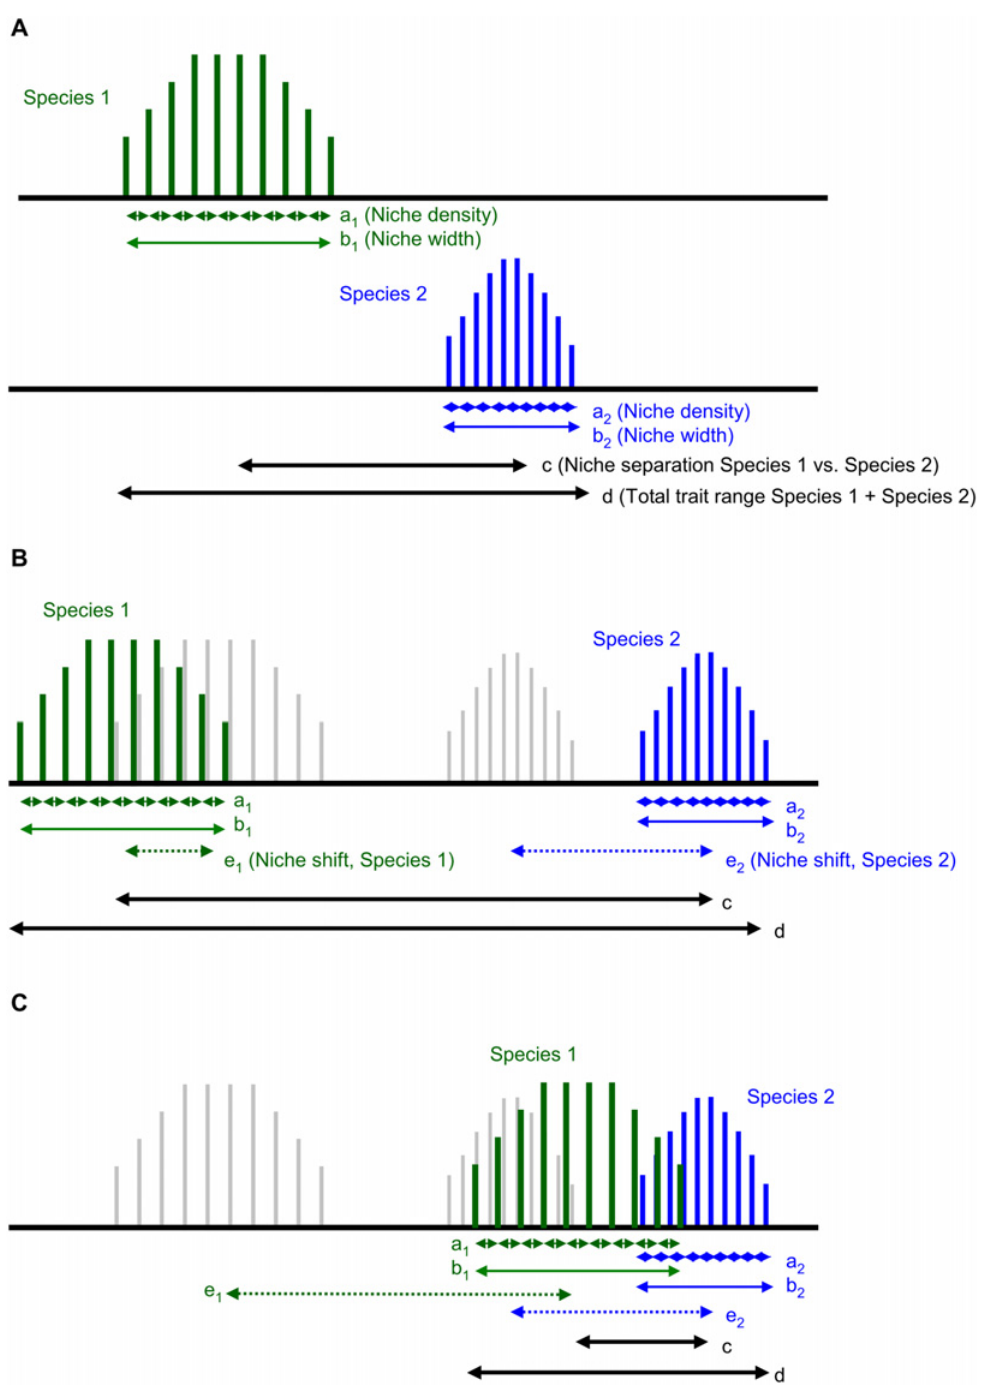
Fig 1. Quantification of species niches along a trait axis. For simplicity only two species (Species 1, Species 2) are considered in monoculture (A) and in a scenario for (B) trait divergence and (C) trait convergence in mixture. Arrows indicate the extent of niche density (a 1 , a 2 ) and niche width (b 1 , b 2 ) for each species in the monoculture and the mixture, niche separation between Species 1 and Species 2 (c), the total trait range across both species (d), and niche shift (e 1 , e 2 ) of each species in the mixture compared to the monoculture. Grey — shaded lines in (B, C) visualize the position of Species 1 and Species 2 respectively in monoculture.